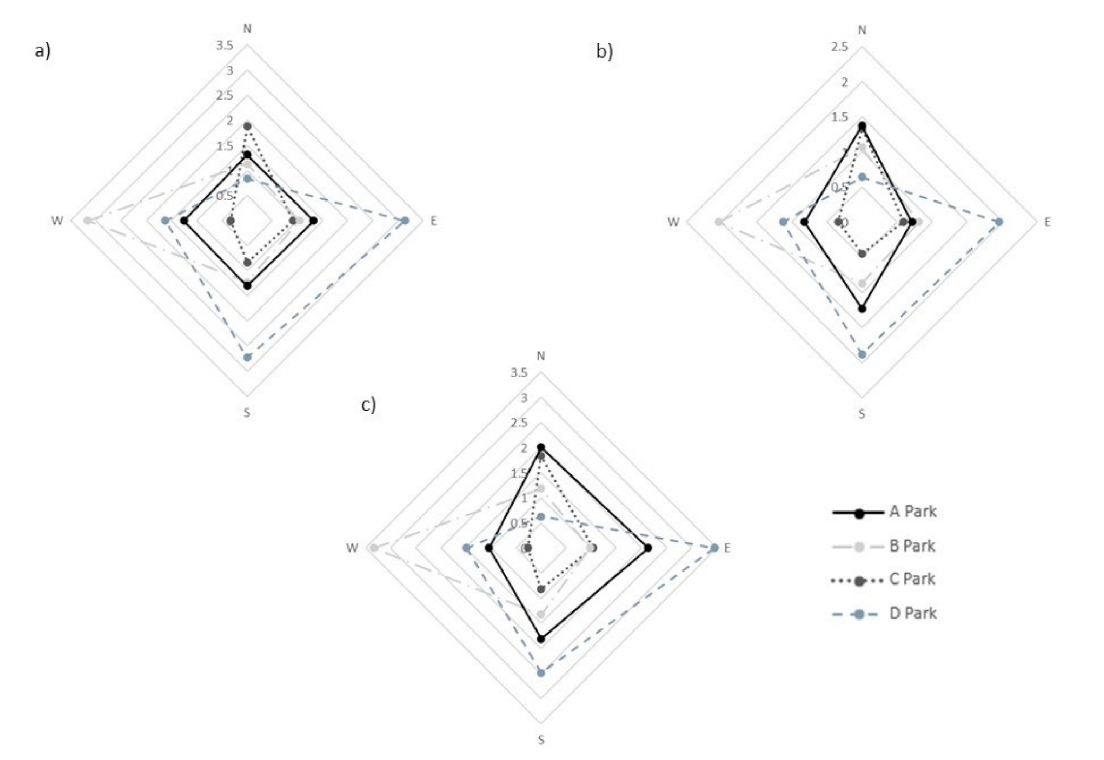
Figure 4. Radar diagrams of park cooling gradient (PCG) ( ◦ C/100 m) for ( a ) 2017, ( b ) 2018, and ( c )